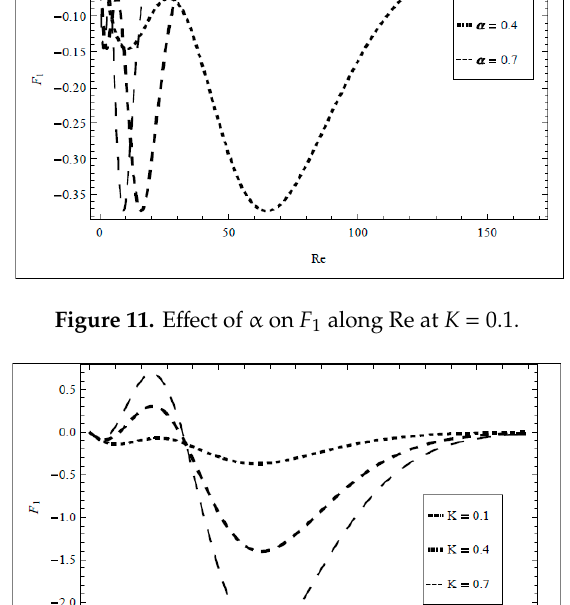
Figure 12. Effect of K on F 1 along Re at α = 0.1.